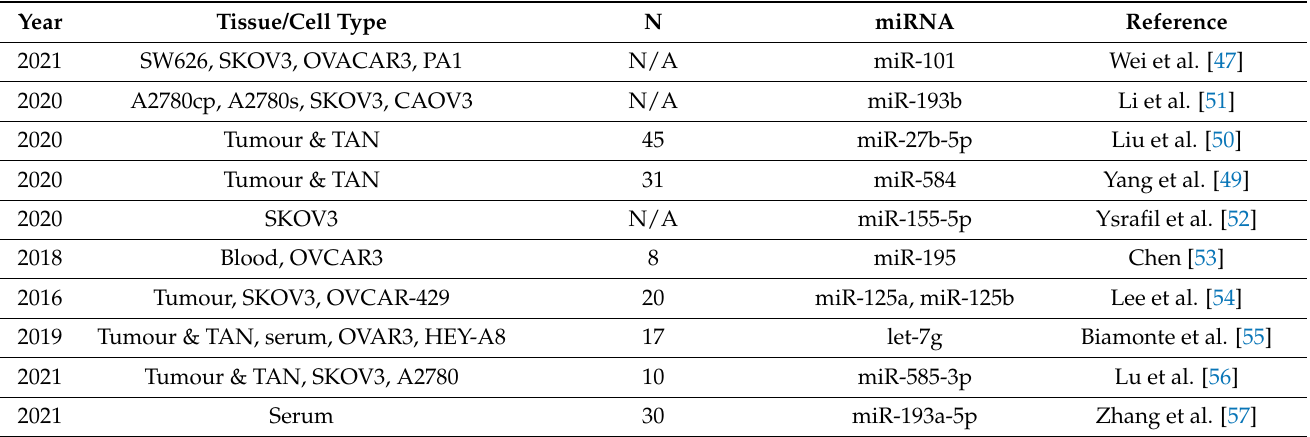
Table 2. MiRNAs downregulated in ovarian